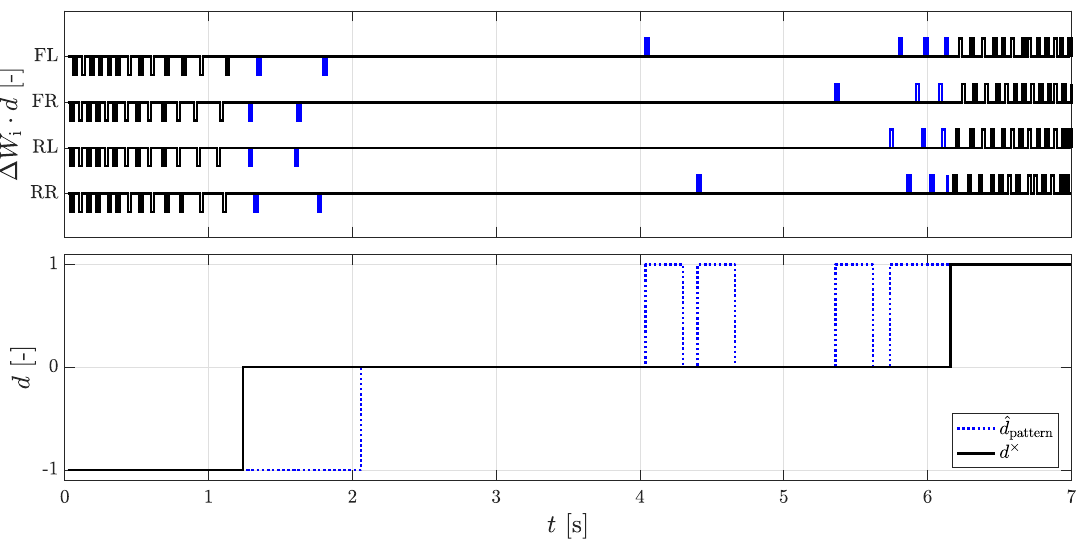
Figure 3. ( Top ): Undefined (blue) and defined (black) DWPCs using the pattern recognition method for detection of rolling directions; ( Bottom ): The rolling directions of the DWPC signal d × and the pattern recognition method ˆ d pattern